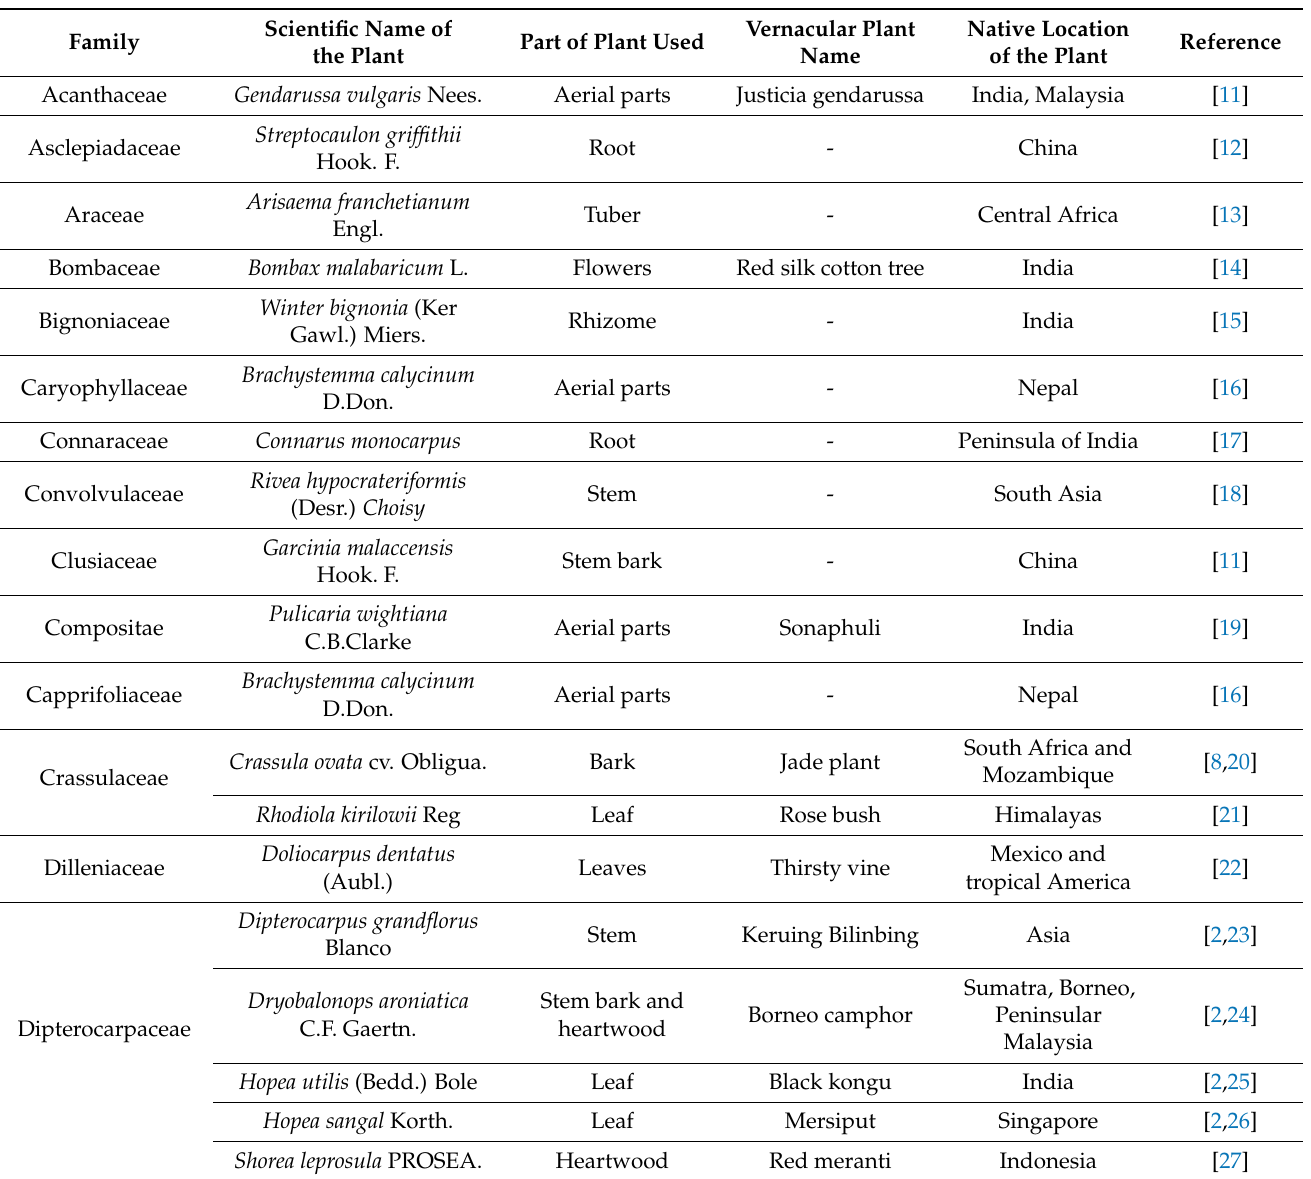
Table 1. Plant species with bioavailability of